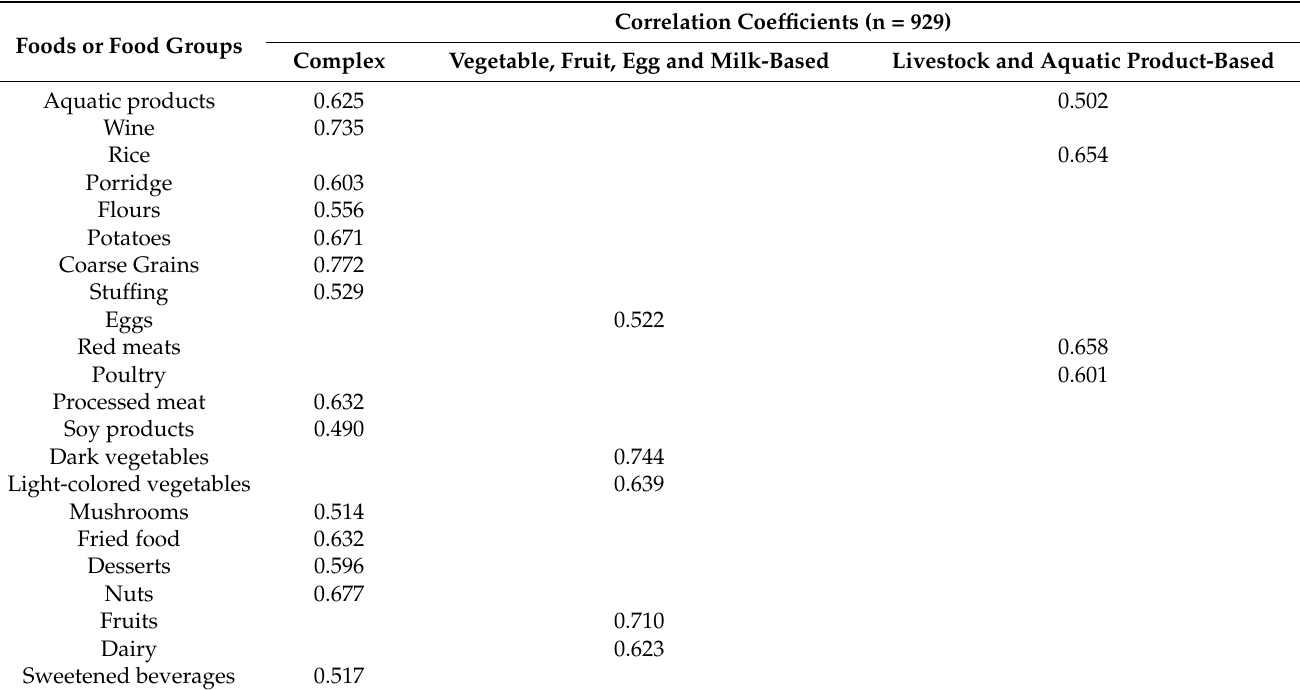
Table 3. Distribution of factor loadings for each food or food group across the three dietary patterns of university students.